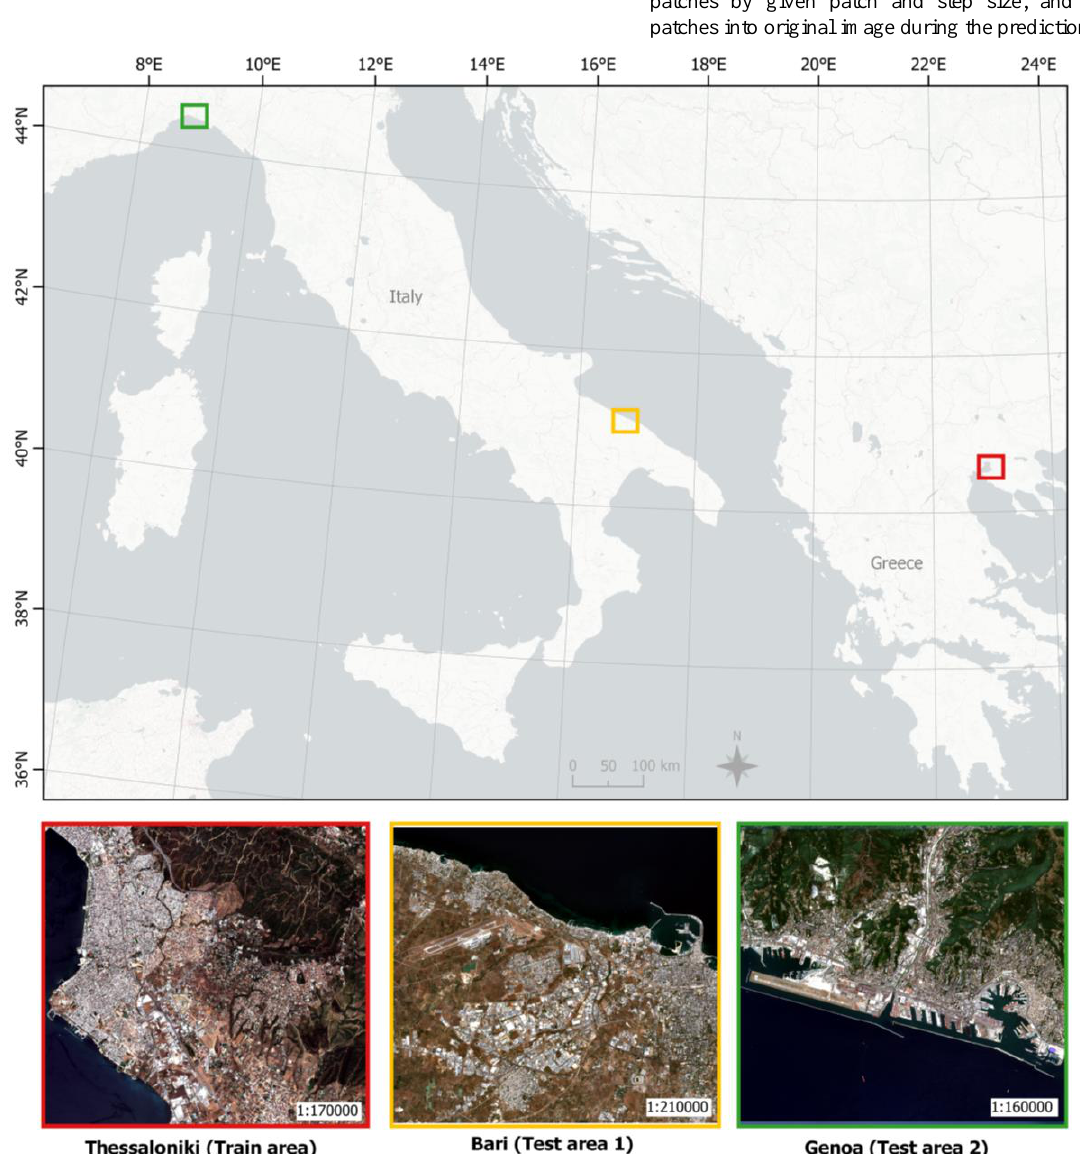
Figure 1 . Location map of the train area and test regions and the corresponding Sentinel-2 natural color composite subset